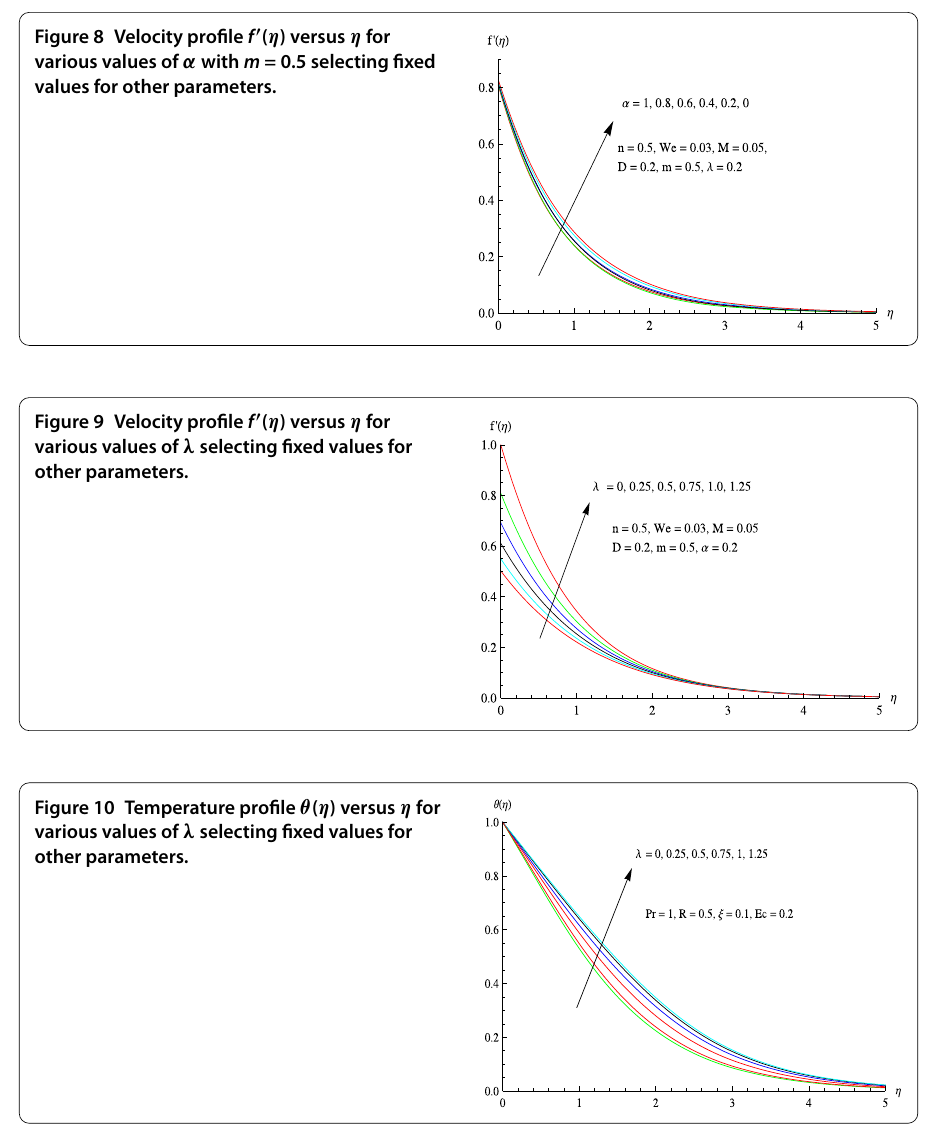
Figure 8 Velocity profile f (cid:2) ( η ) versus η for various values of α with m = 0.5 selecting fixed values for other parameters.